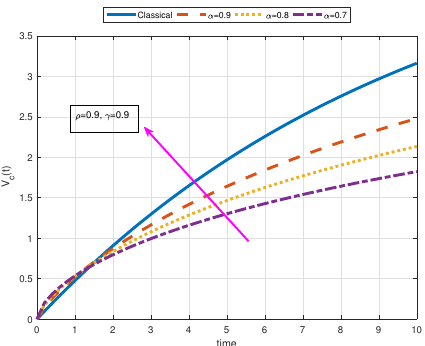
Figure 3. This figure corresponds to the function V c ( t ) with a constant source for different values of α , ρ , and γ in order to show the effect of α on solution curves when R = 1 Ω , C = 10 F, e 0 = 5 V, and V c ( 0 ) = 0.